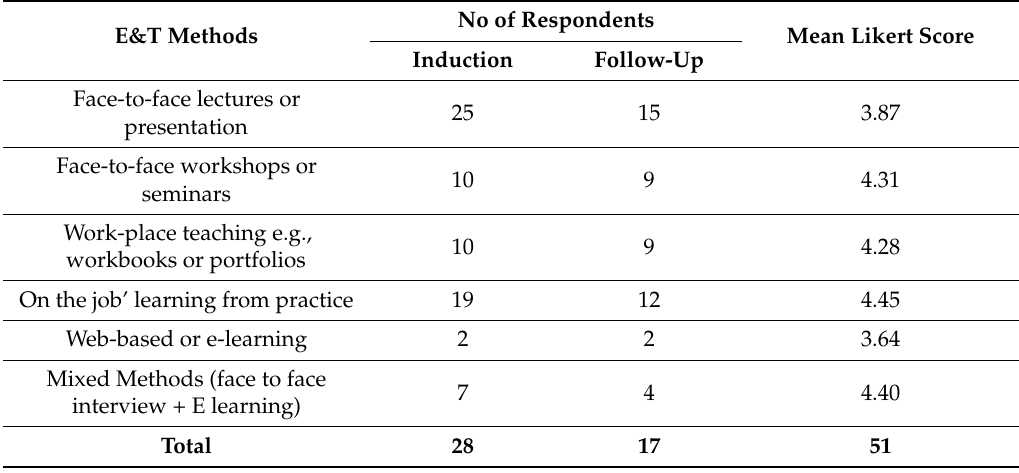
Table 2. Preferred methods of E&T for Antimicrobial Stewardship (AMS). Likert score range was 1 (Least preferred) to 5 (highly